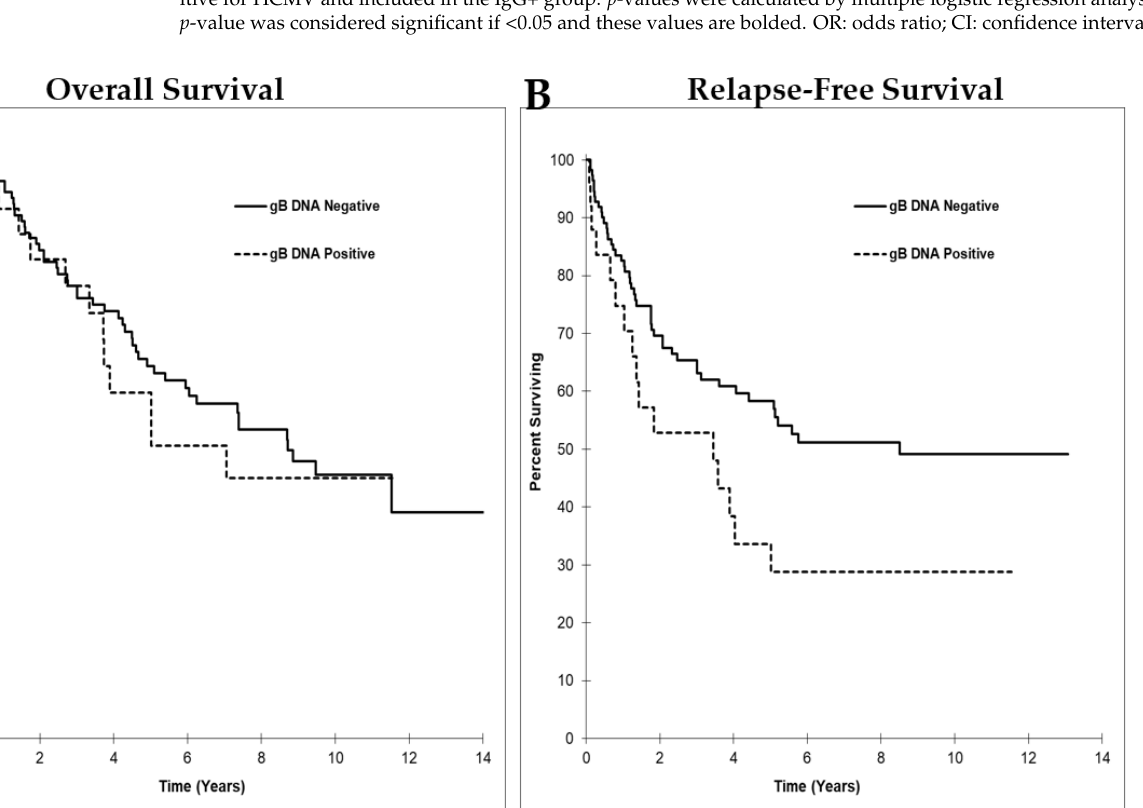
Figure 4. Kaplan–Meier survival curves based on HCMV gB DNA detection in breast tumors. ( A ) Overall survival and ( B ) Relapse-free survival. N = 136. p -values were calculated by the Chi-square